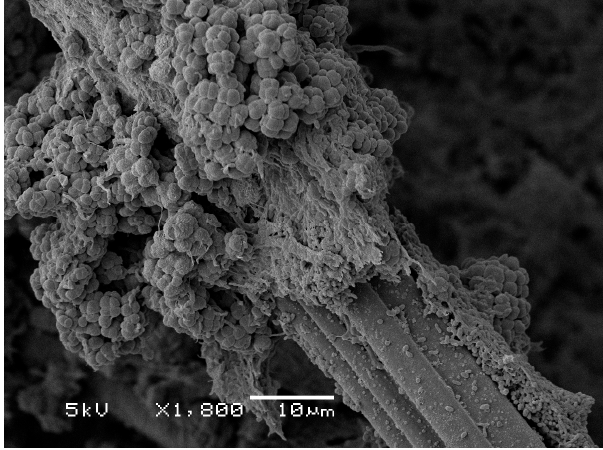
Figure 2. Biofilm developed on the fibers of an anode felt electrode collected from a microbial electrolysis cell [19]. An electrogenic biofilm can clearly be seen on the surface of the graphite fiber, which is covered by methanogenic